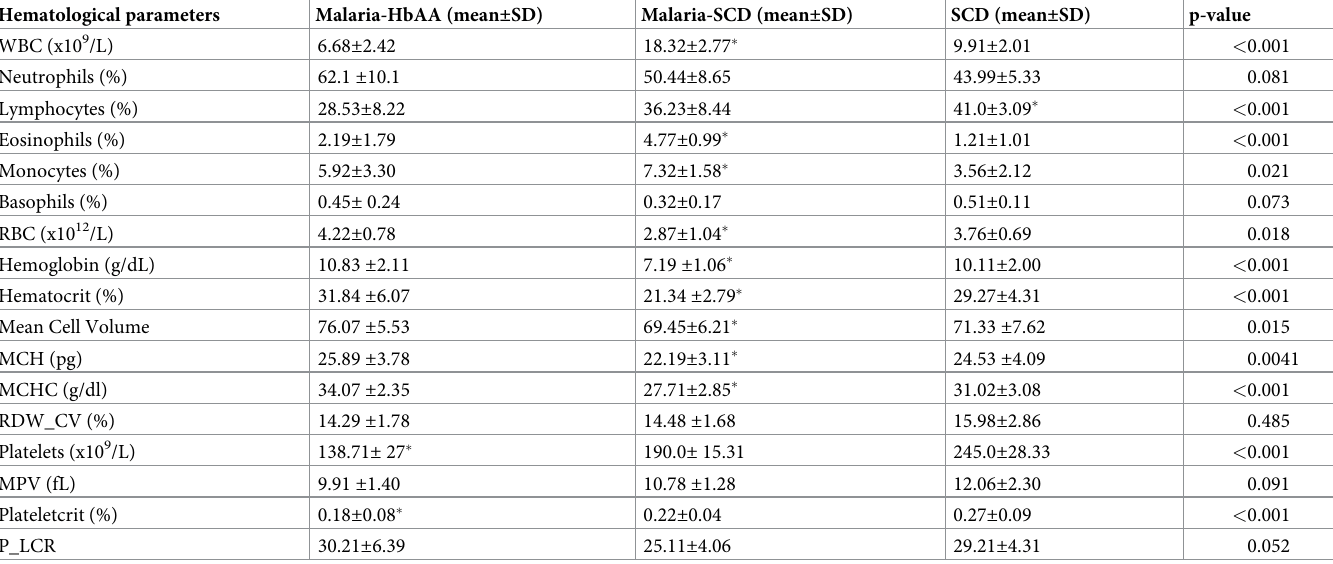
Table 5. Hematological parameters associated with malaria, SCD and malaria-SCD comorbidity. Hematological parameters